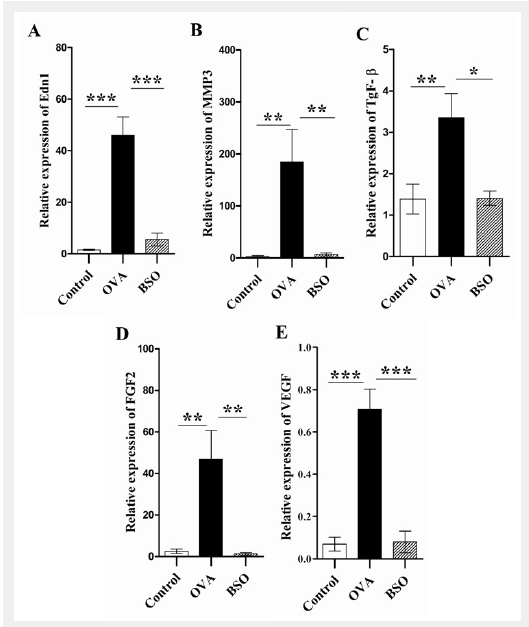
Black seed oil abrogated the mRNA expression of Edn1 and MMP3 and growth factors in the lungs. Total RNA was extracted from the lung of experimental rats and used in real time RT-PCR to determine mRNA expression of Edn1, MMP3 and growth factors, while β-actin was used as the reference gene. Relative mRNA expression of Edn-І (A), MMP3 (B), TGF-β (C), FGF2 (D) and VEGF (E) was expressed as mean ± S.E.M. *P <0.05, **P <0.01 and *** P <0.001 by comparing two